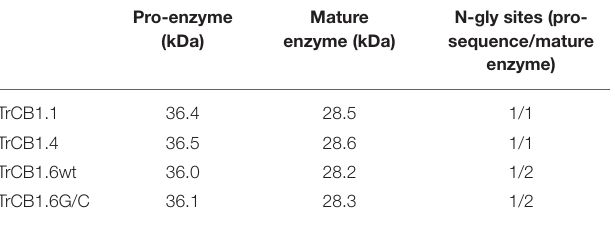
TABLE 1 | Theoretical molecular weight and number of potential N-glycosylation sites of pro-enzymes/mature TrCB1 forms. Pro-enzyme Mature N-gly sites (pro- (kDa) enzyme (kDa)